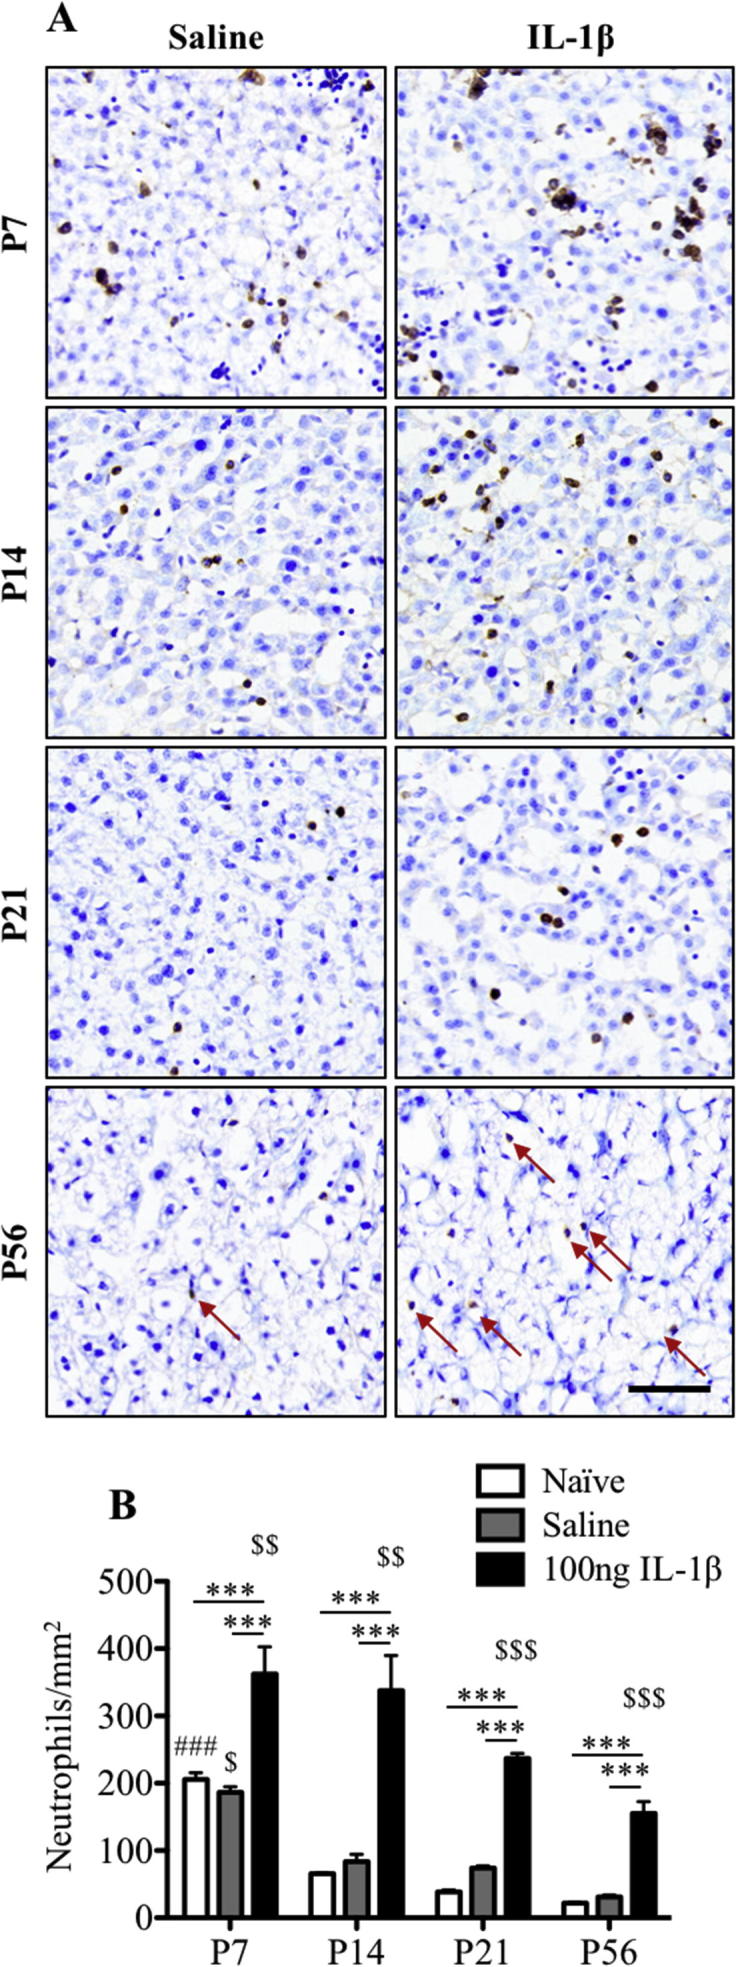
Neutrophil recruitment to the liver 4 h after intracerebral injection of 100 ng IL-1β. Immunohistochemistry for neutrophils revealed higher numbers of cells in the liver following intracerebral injection of 100 ng IL-1β at all ages compared to naïve or saline injected animals (A). The greatest response was observed in the youngest animals (B). Scale bar = 50 µm. ∗∗p < 0.01 and ∗∗∗p < 0.001. ###p < 0.001 vs. all naïve values, $ significantly different from all saline values, $$ significantly different from 100 ng P21 and P56 and $$$ significantly different from all 100 ng values. P7: n = 3 each group, P14: n = 3 each group, P21: n = 3 each group and P56: n = 4 for naïve and saline, n = 7 for 100 ng IL-1β.